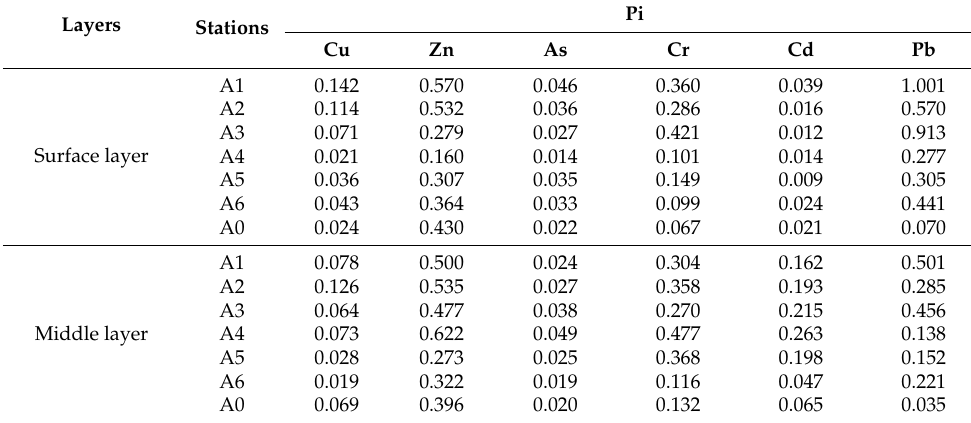
Table 5. Single factor pollution index (SFI) of heavy metals in barnacles.